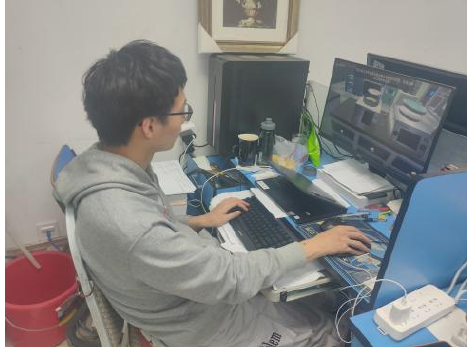
Figure 22. Student performing an experiment at home.